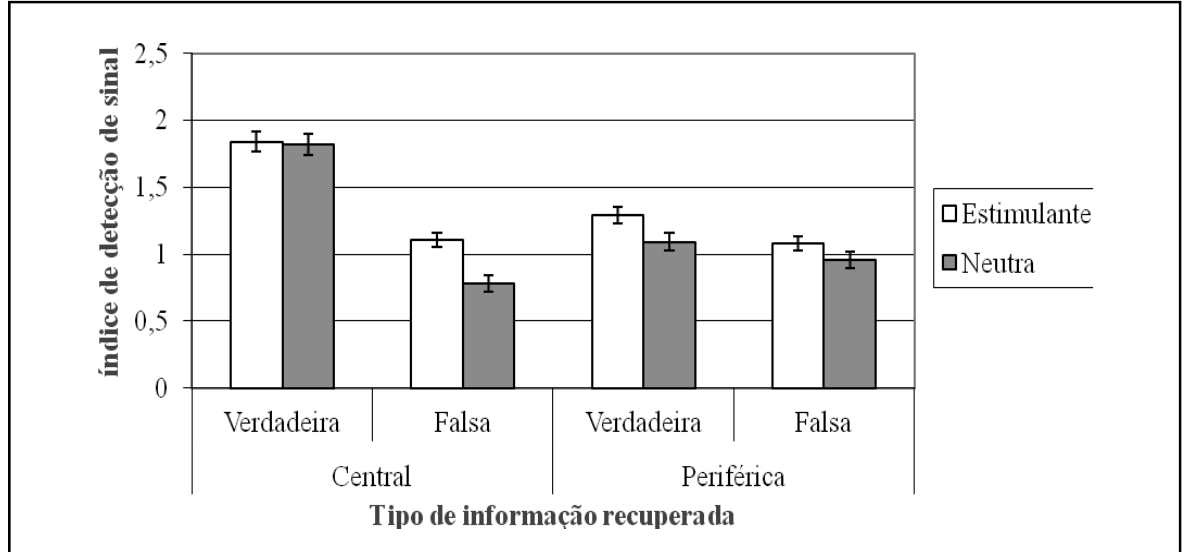
Figura 1 . Índices de detecção de sinal verdadeiro e falso de informações centrais e periféricas por versão da história ( p < 0,05 entre versões da